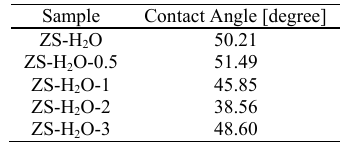
Table 3. Water droplet angle of the synthesized samples.